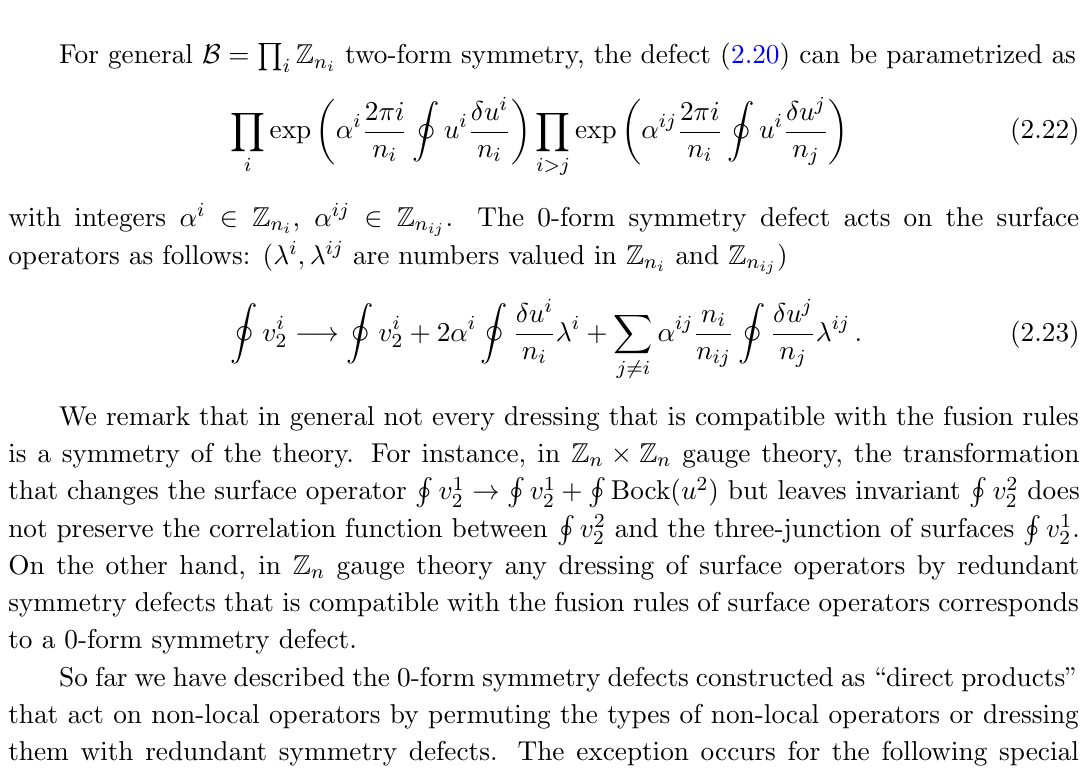
Figure 3 . The junction of two Z 2 0-form symmetry defects (2.24) (indicated by the black solid line) fusing into the trivial defect (indicated by the dashed line). The 0-form symmetry defects meet at the codimension-two red surface. The black arrows indicate their orientations. Intersecting the junction with the green surface H v 2 (that (cid:12)lls the plane in the (cid:12)gure) emits an additional symmetry line defect H u (indicated by the blue line) on one of the two